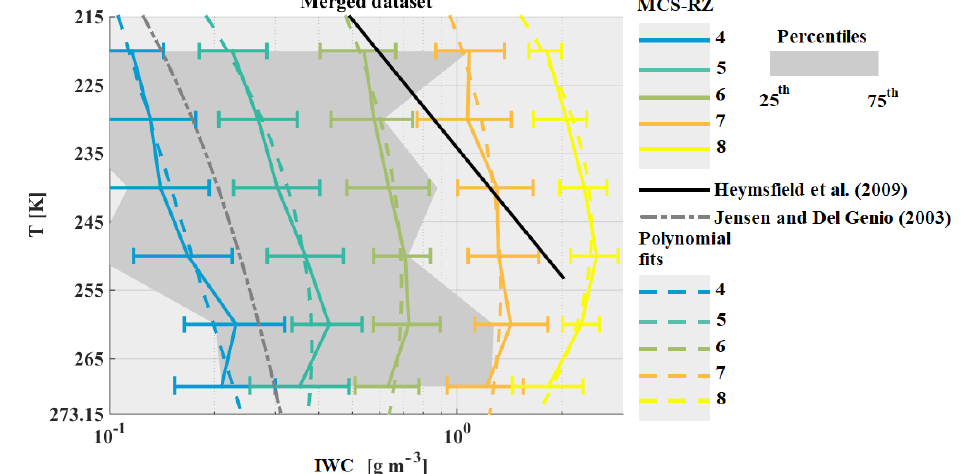
Figure 5. The median of IWC in gm − 3 given on the x axis, as a function of temperature in K on the y axis for different MCS reflectivity zones. Results for the merged dataset include both MT and HAIC-HIWC datasets. The grey band represents the 25th and 75th percentiles of the merged dataset. The extremities of the error bar show the 25th and 75th percentiles of IWC in each MCS-RZ. Lines are color coded as a function of the MCS reflectivity zones where in situ measurements were performed, and dashed color-coded lines represent the polynomial